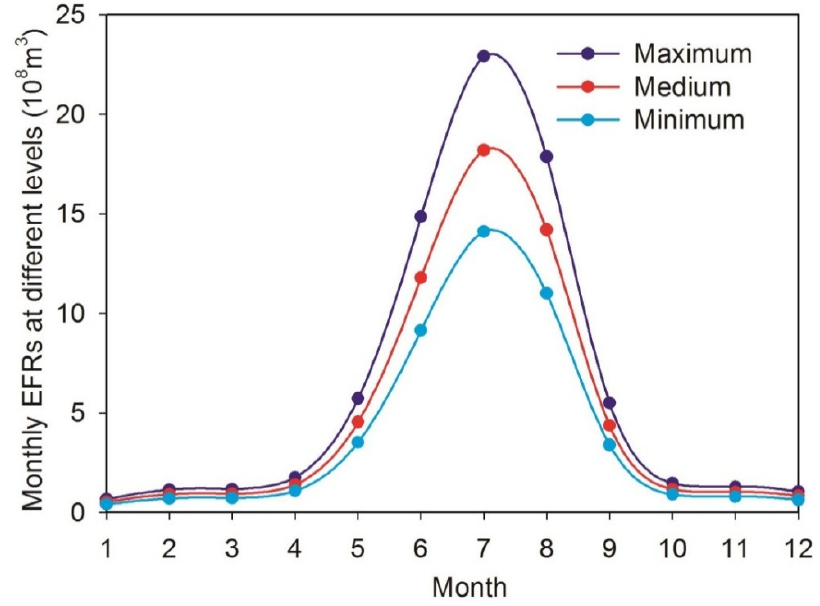
Figure 5. Monthly EFRs for multiple ecosystem functions at different levels (Maximum, Medium, and Minimum) in Qira